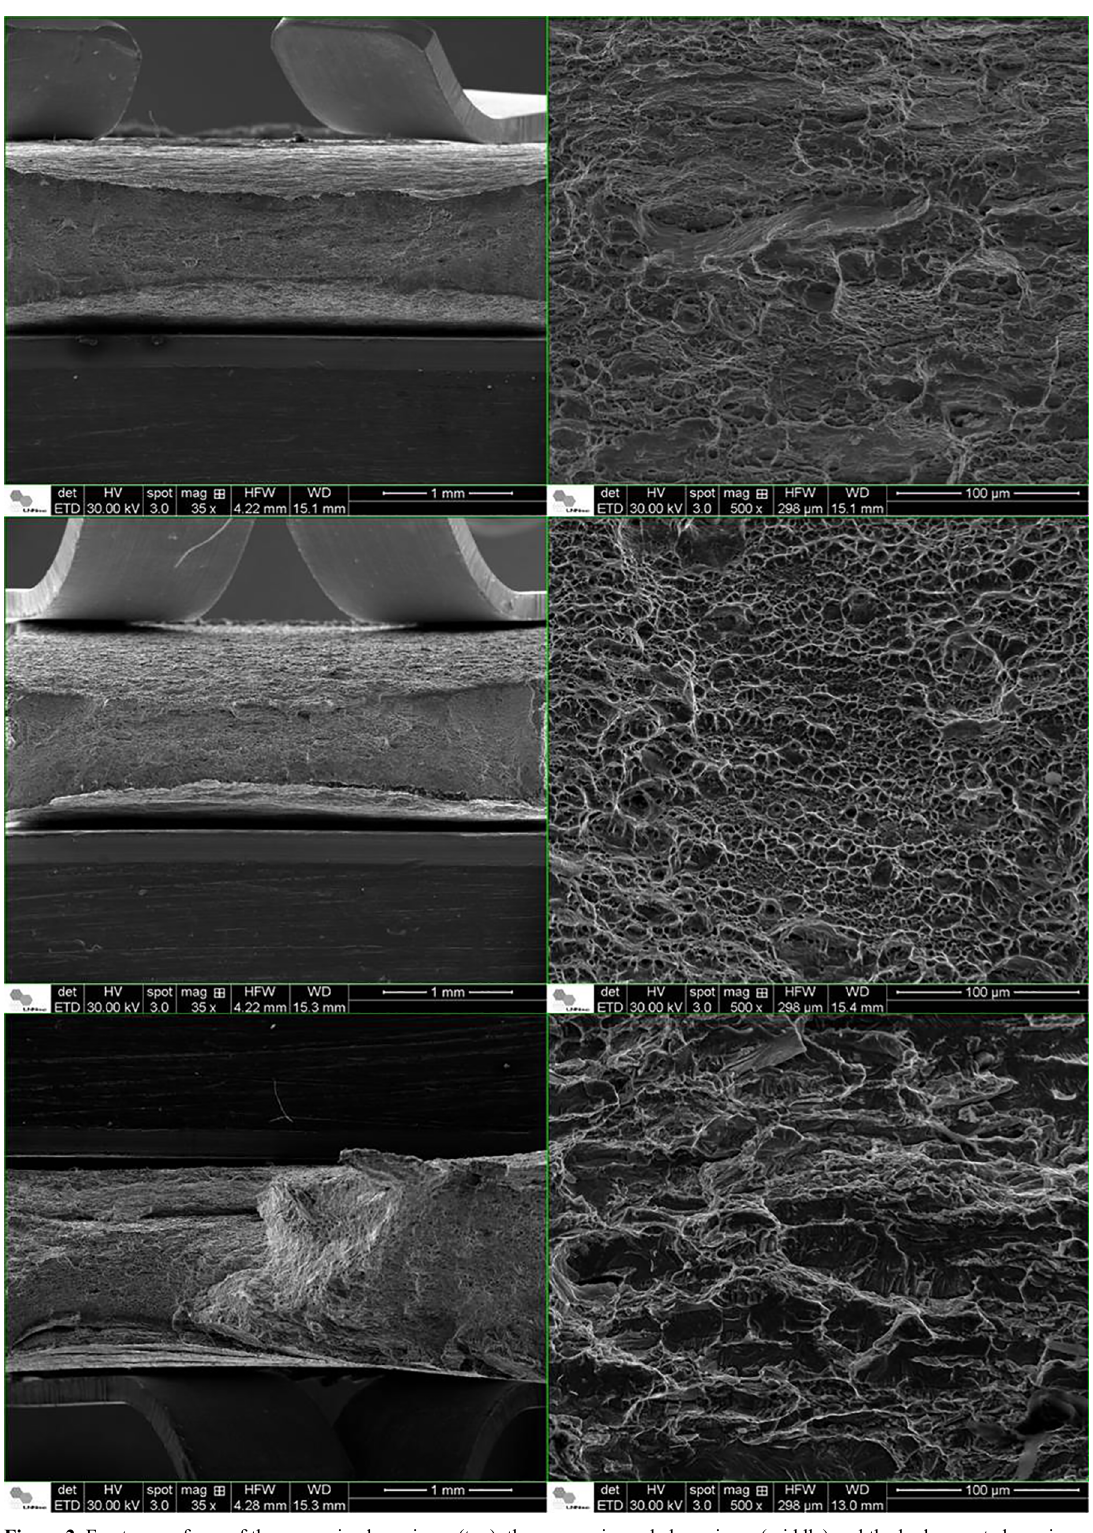
Figure 2. Fracture surfaces of the as-received specimen (top), the cryogenic cooled specimen (middle) and the hydrogenated specimen